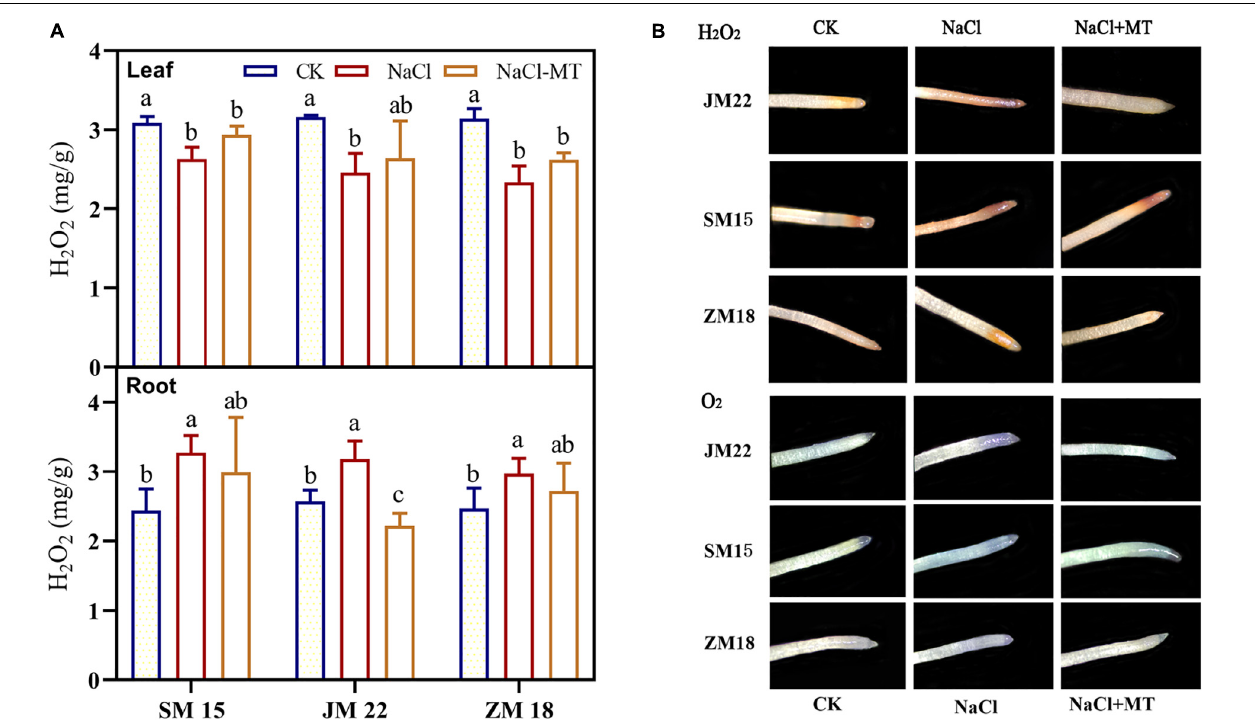
FIGURE 7 | Effects of MT on hydrogen peroxide (H 2 O 2 ) content in plant (A) and H 2 O 2 and upper-oxide anions (O 2 − ) distribution in root (B) under salt stress. For each trait, bars with the same letter are not significantly different according to Duncan’s test at a p < 0.05 threshold.